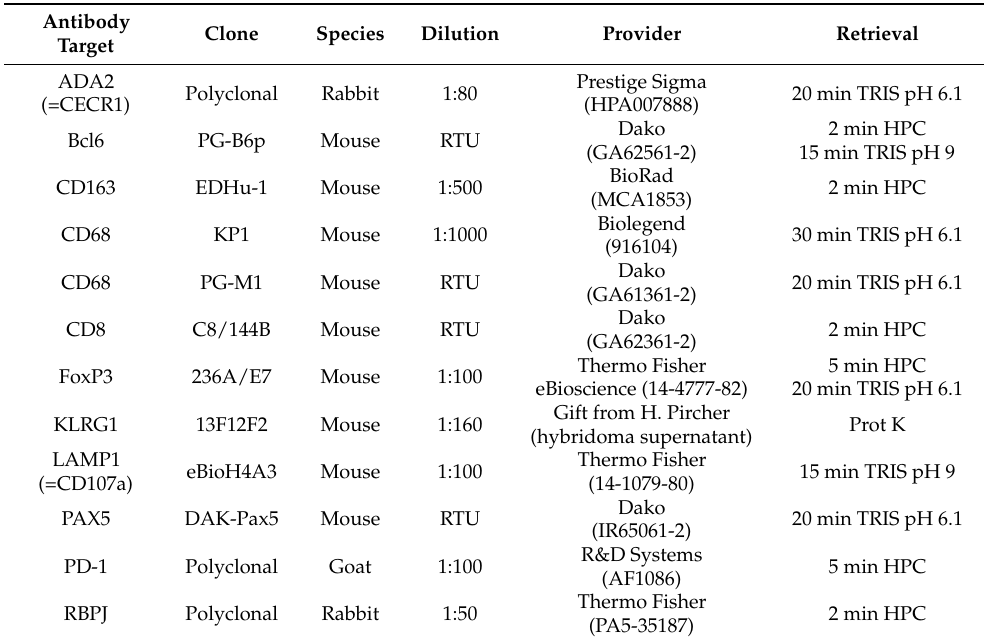
Table 1. Primary antibodies used, including retrievals. Abbreviations: RTU: Ready to use, HPC: high pressure cooking at 120 ◦ C in citric buffer